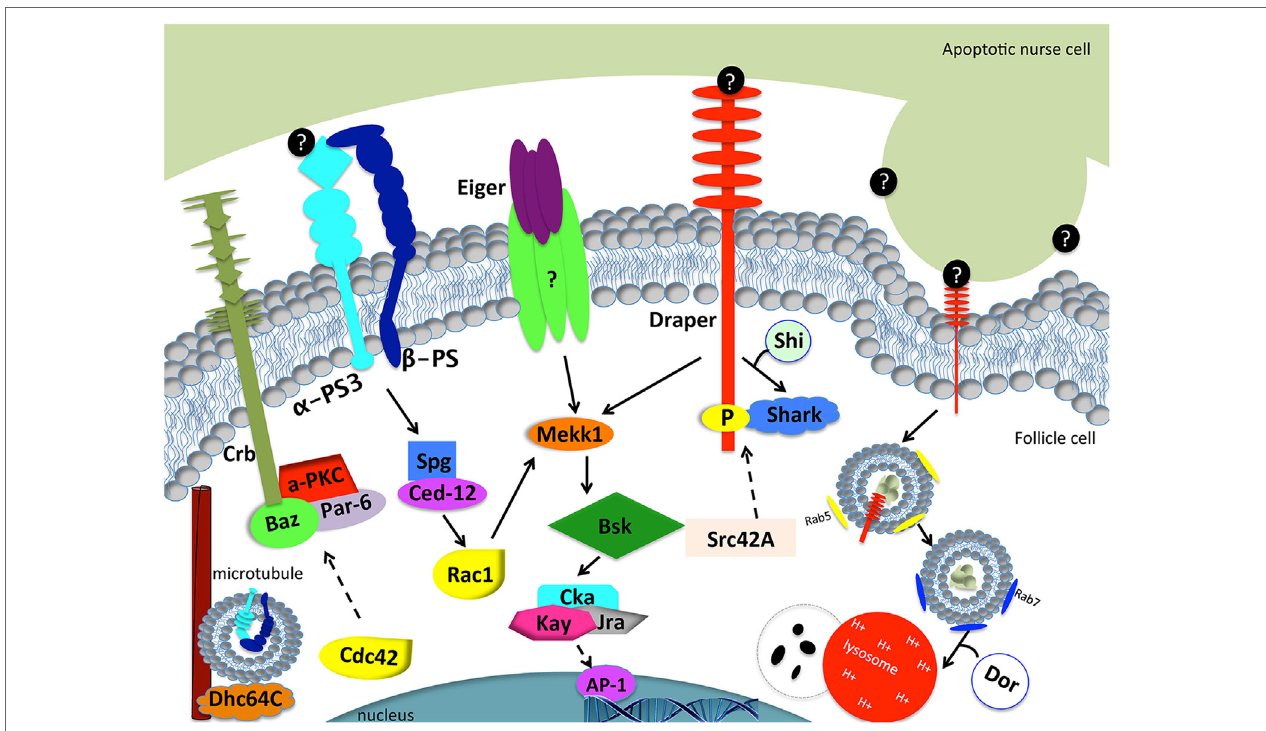
FiGURe 3 | Model of engulfment by follicle cells in the Drosophila ovary. Apoptotic cell recognition (left side): Draper binds to an unknown “eat me” signal (black circles) and activates the JNK signaling cascade (Mekk1, Bsk, Cka, Kay, Jra) through Shark to mediate engulfment. Eiger may or may not interact with a TNF receptor to activate the JNK signaling pathway. α -PS3/ β -PS integrin heterodimer signals through Spg and Ced-12 to activate Rac1. Rac1 also activates the JNK signaling pathway. The Crb/Baz, Par-6, and aPKC polarity proteins are also required for engulfment. Dhc64C assists in the trafficking of α -PS3/ β -PS. Phagosome maturation (right side): Draper is required for nurse cell phagosome maturation. Draper and corpse material first become enclosed in Rab-5 positive phagosomes and mature into Rab-7 positive phagosomes, until the phagosome fuses with lysosomes for degradation. Shi is required for early phagosome maturation. Dor is required for phagosome and lysosome fusion. Dashed arrows correspond to proteins that were tested without epistasis analysis and have engulfment defects. Question marks correspond to unknown